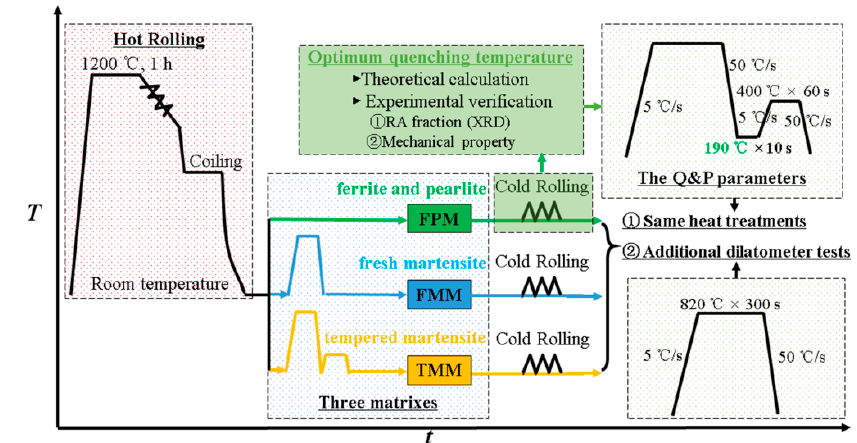
Figure 3. Entire experimental design roadmap and specific heat treatment parameters.